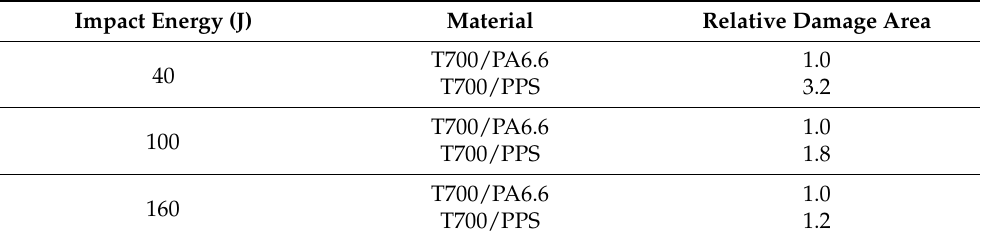
Table 4. Summary of damage areas relative to the T700/PPS system in comparison to T700/PA6.6. Impact Energy